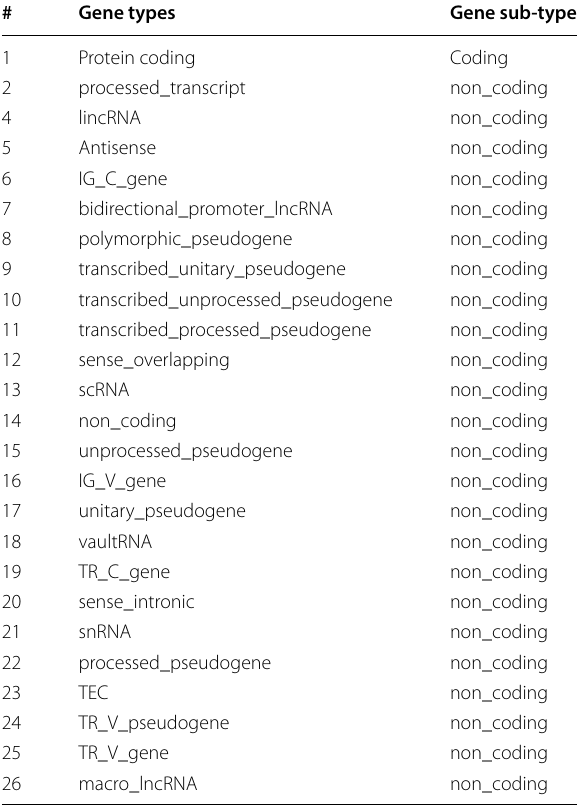
Table 1 PAS-Gen database description: type and sub- types of genes